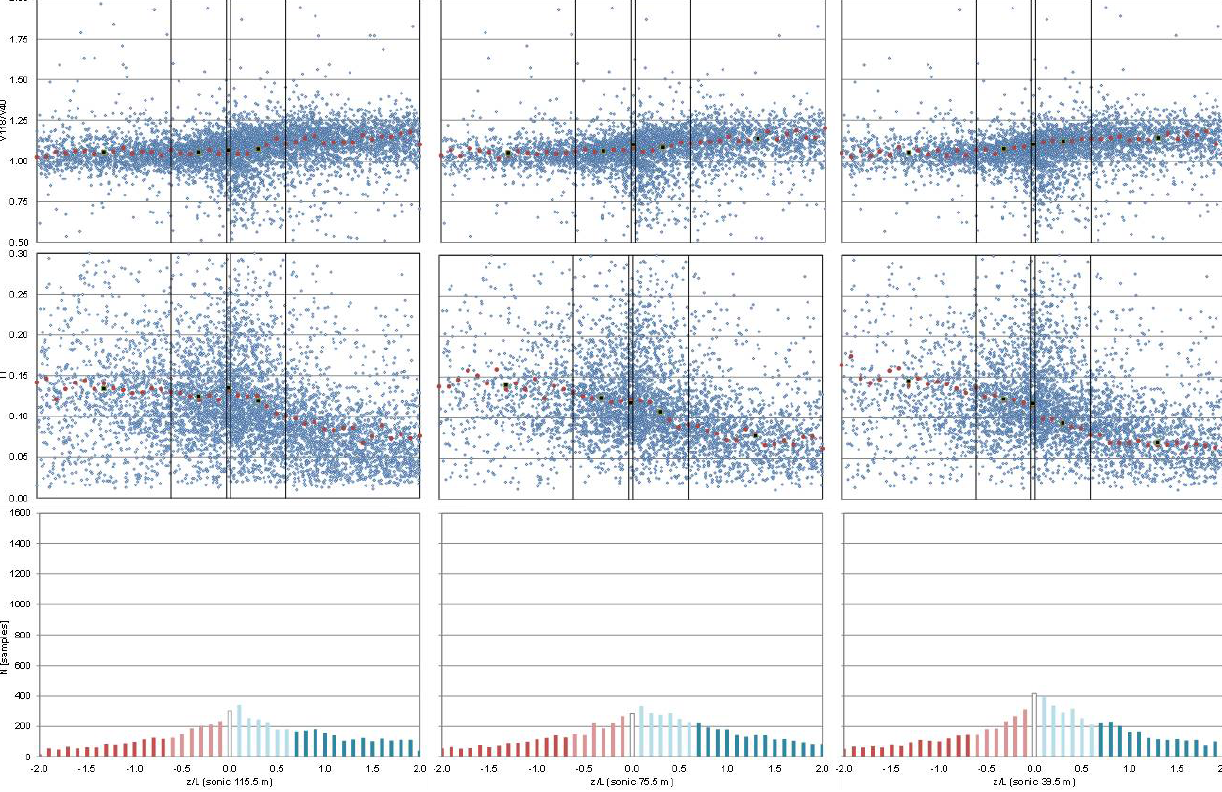
Figure 10. Wind shear and turbulence intensity vs. sonic stability in the MP5 157.5–202.5 ◦ sector. Red dots are the z/L mean values for the 0.01 resolution scale, and black squares are the z/L mean values in each of the stability classes according to Table 1.